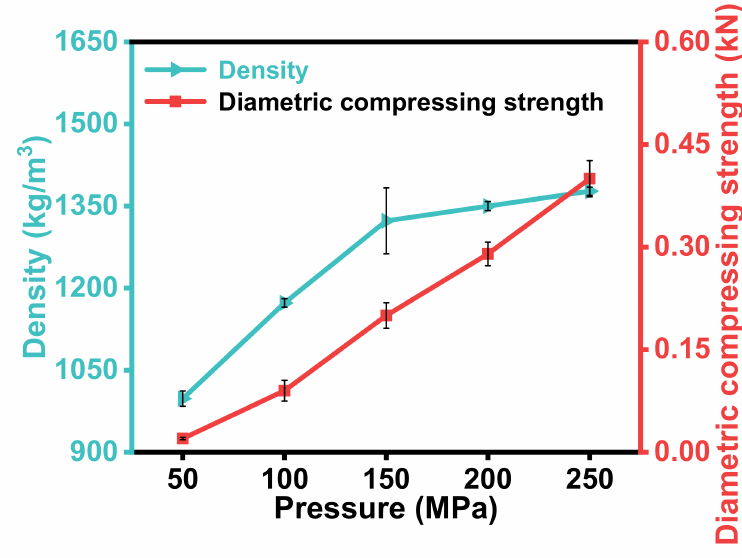
Figure 2. Density and diametric compressive strength of the pellet under different